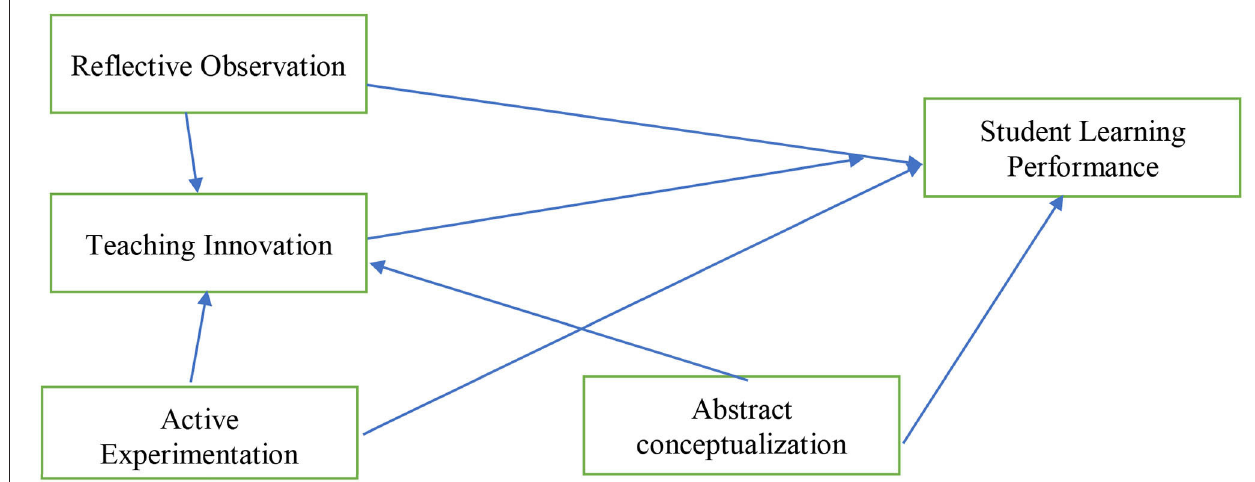
FIGURE 1 | Theoretical framework. RO, reflective observation; TI, teaching innovation; AE, active experimentation; AC, abstract conceptualization; SLP, students’ learning performance.